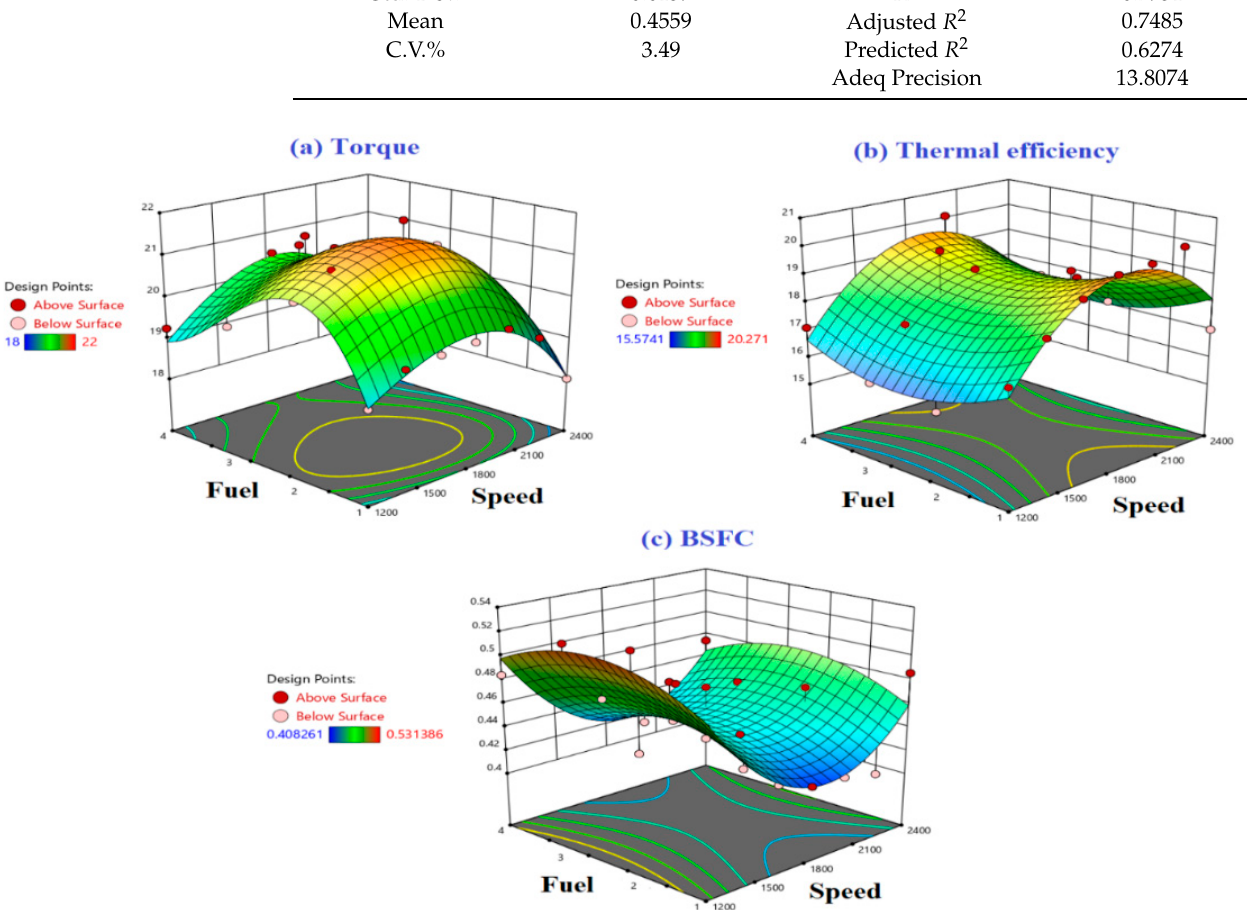
Figure 12. 3D response surface plots for three output responses.